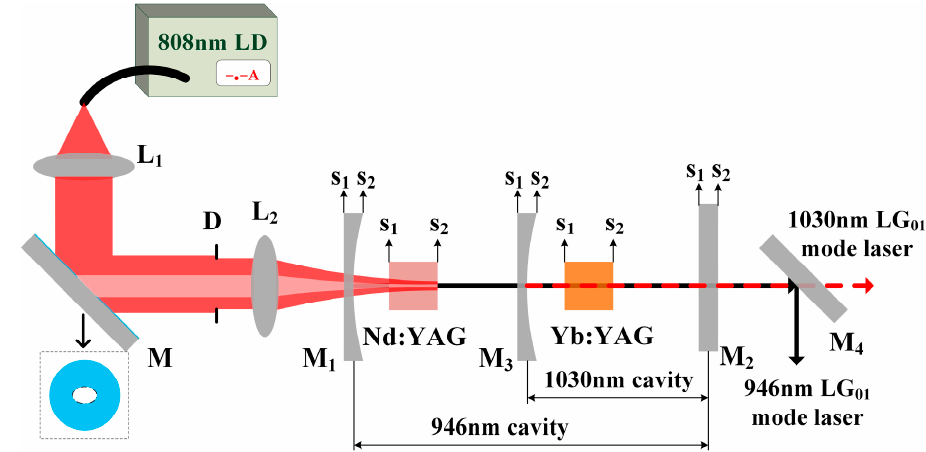
Figure 5. The experimental setup of the 946/1030 nm dual-wavelength LG 01 mode laser.